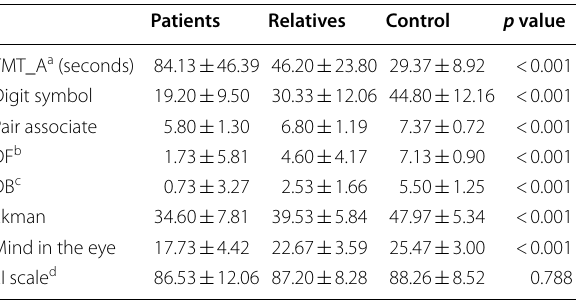
Table 2 Comparison between the three groups as regards basic and social cognition